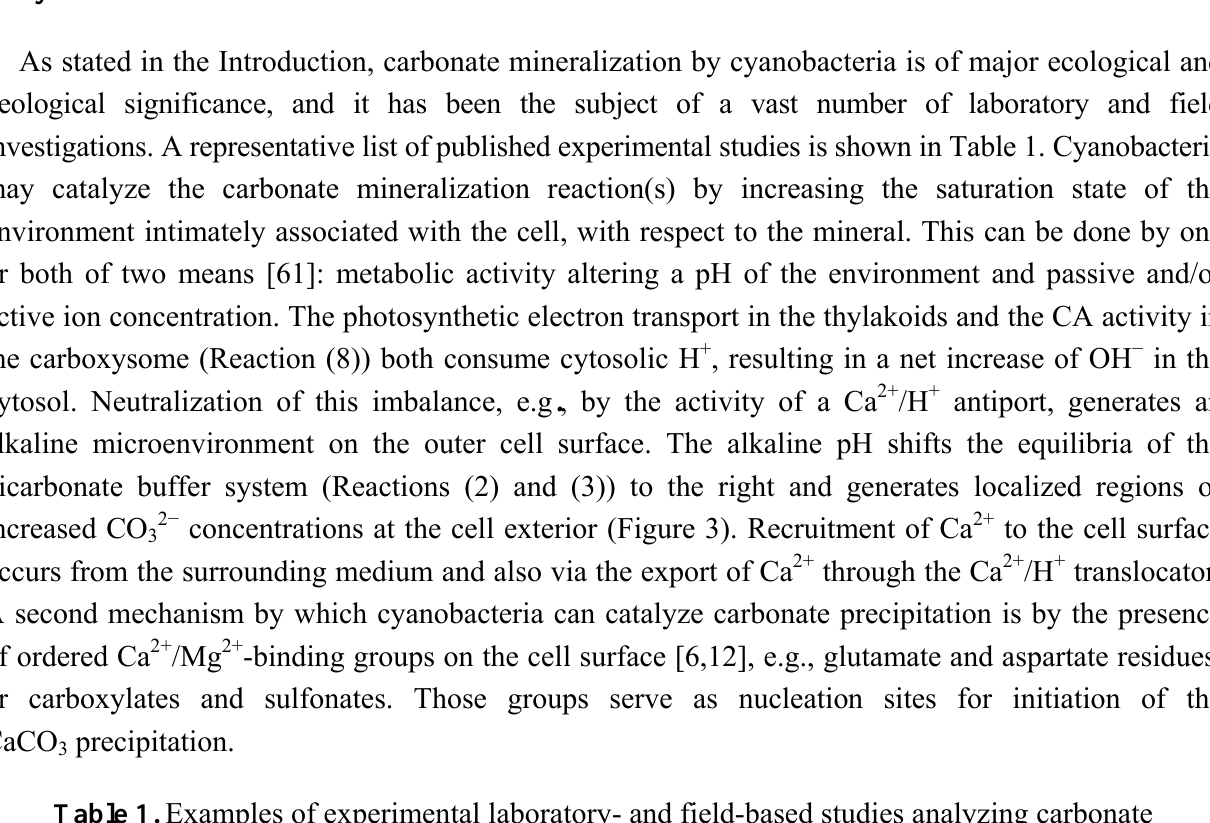
Table 1. Examples of experimental laboratory- and field-based studies analyzing carbonate precipitation mediated by cyanobacterial cultures and communities. Abbreviations: